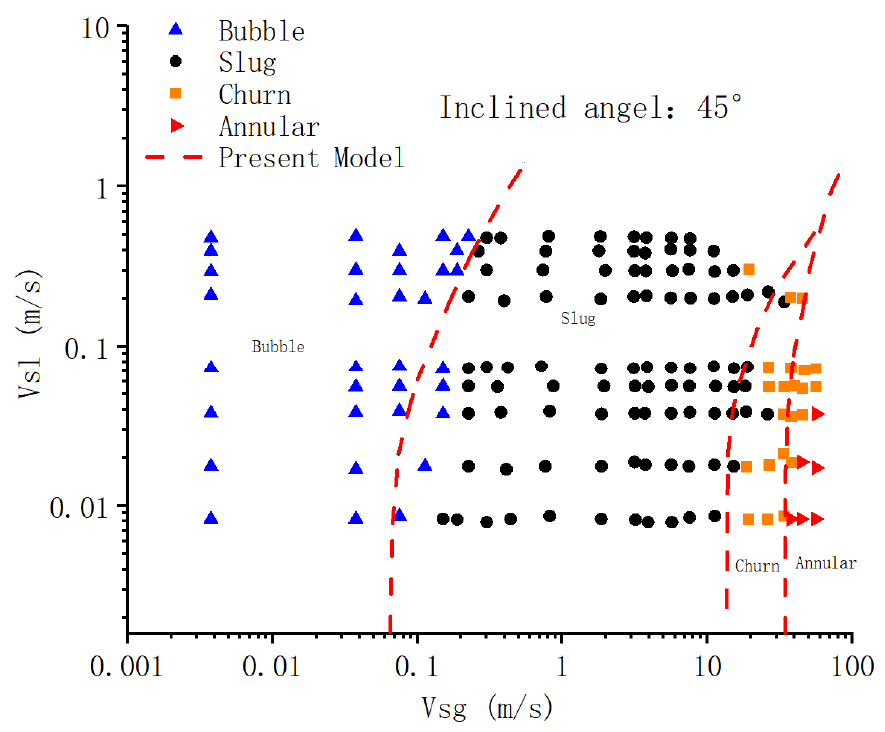
Figure 13. Flow pattern distribution of gas-liquid two-phase flow in the annulus pipe at an inclina- tion angle of 45°.